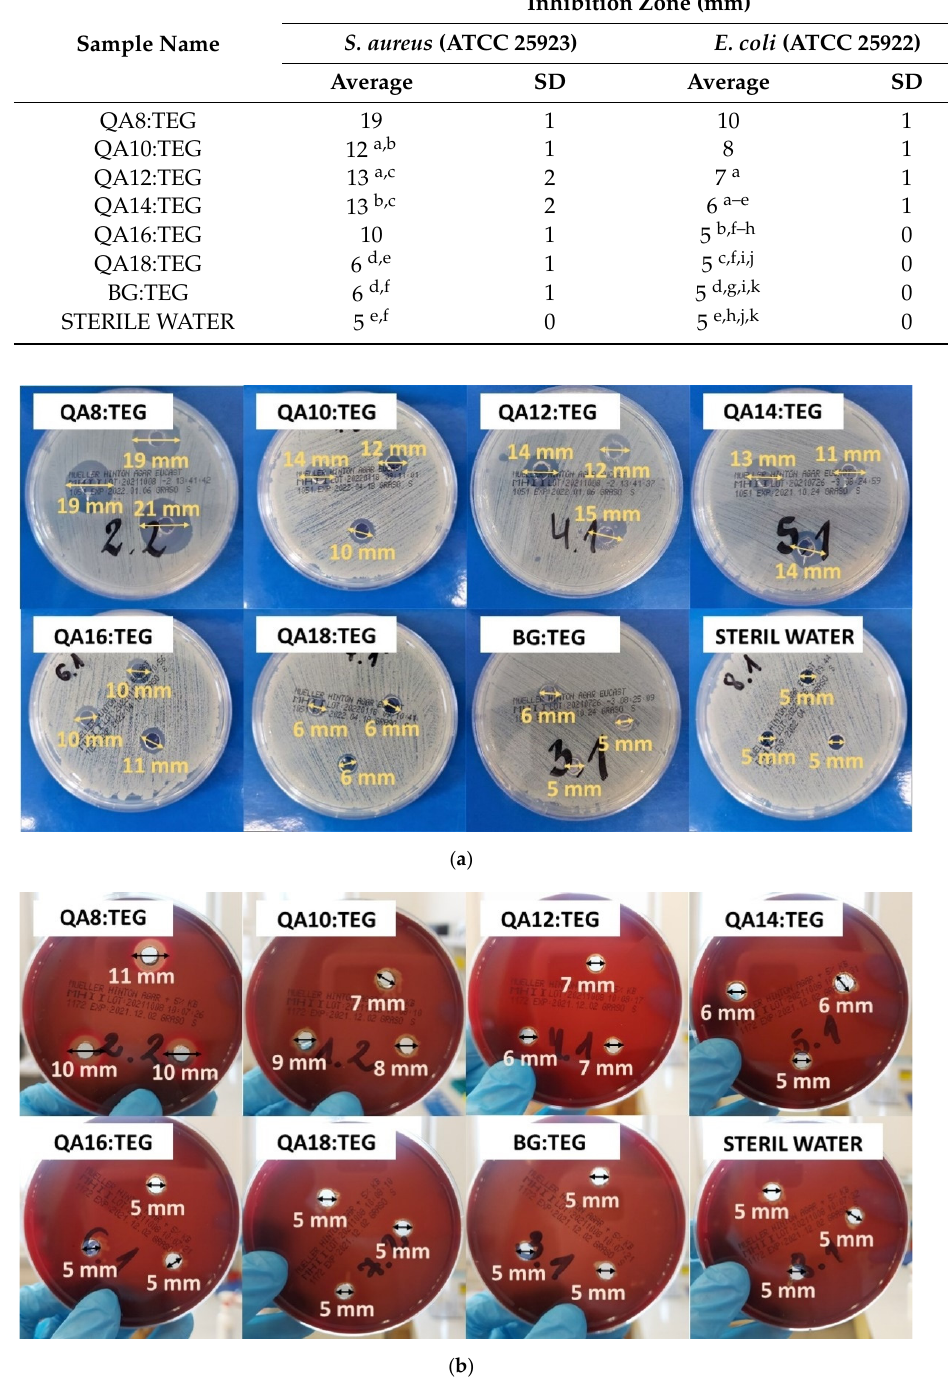
Figure 7. Images showing ( a ) S. aureus (ATCC 25923) and ( b ) E. coli (ATCC 25922) growth inhibition zones.